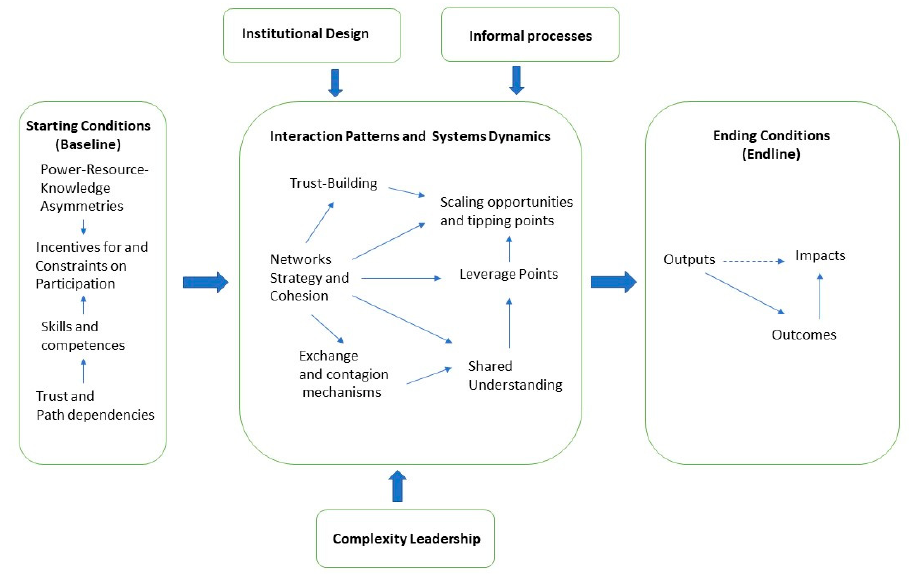
Figure 1. Finnish Schools on the Move as a collaborative governance arrangement.